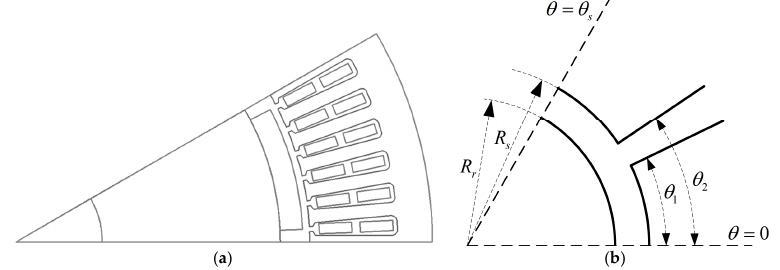
Figure 2. An internal rotor SPM machine example to explain the calculation of the relative air-gap permeance. ( a ) Cross section of one pole pitch of the SPM; ( b ) Infinite slot in the S plane.